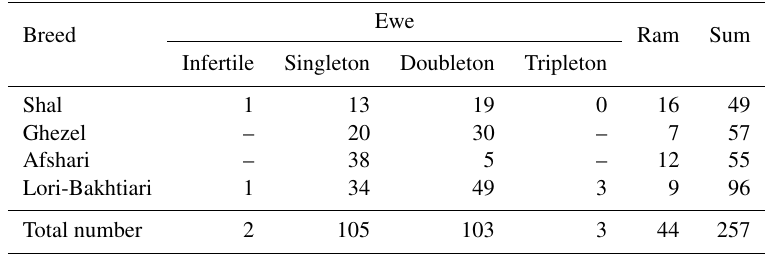
Table 2. Primers and PCR conditions utilized for amplification of exon 1 and exon 2 of the sheep BMP15 gene. Primer sequence Position Amplicon Annealing Extension (5 (cid:48) → 3 (cid:48) ) size temperature temperature R1: